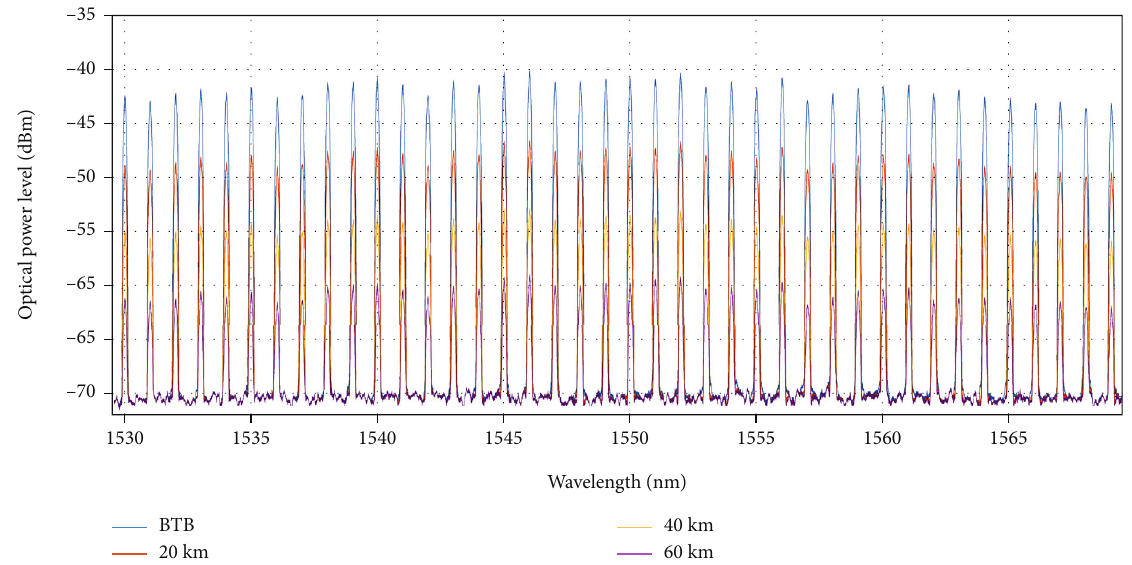
Figure 17: Re fl ected optical signal spectrum of the developed 40 FBG sensor network after BTB, 20, 40, and 60 km